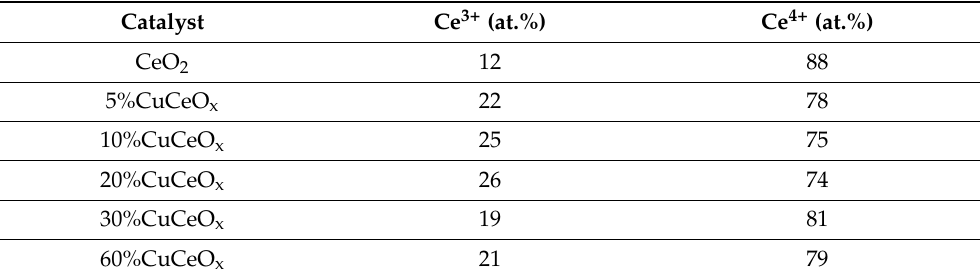
Table 3. Relative amount of Ce species as derived from XP spectra of Ce 3 d core level.